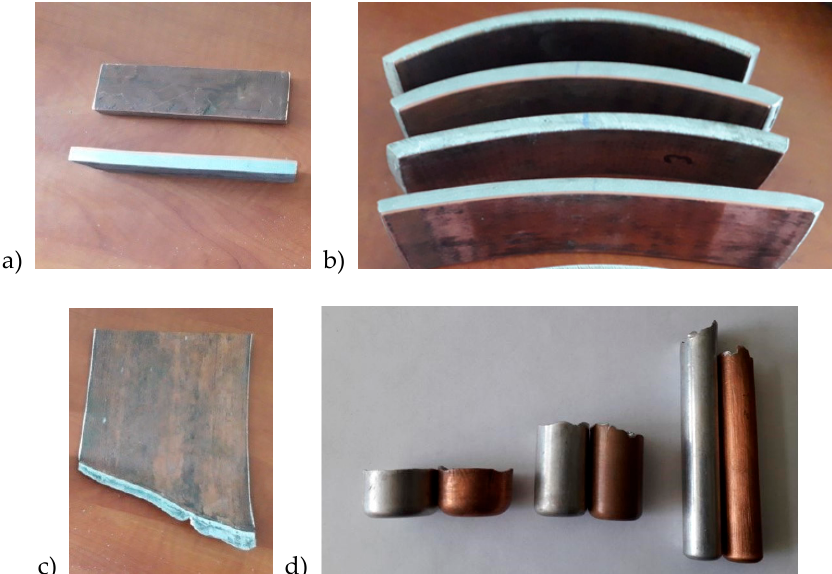
Figure 7. View of samples after subsequent stages of the technological process; ( a ) samples prepared for rolling; ( b ) sample after the last pass of the rolling process; ( c ) final samples after the rolling process; ( d ) samples after the drawing and pressing stages .